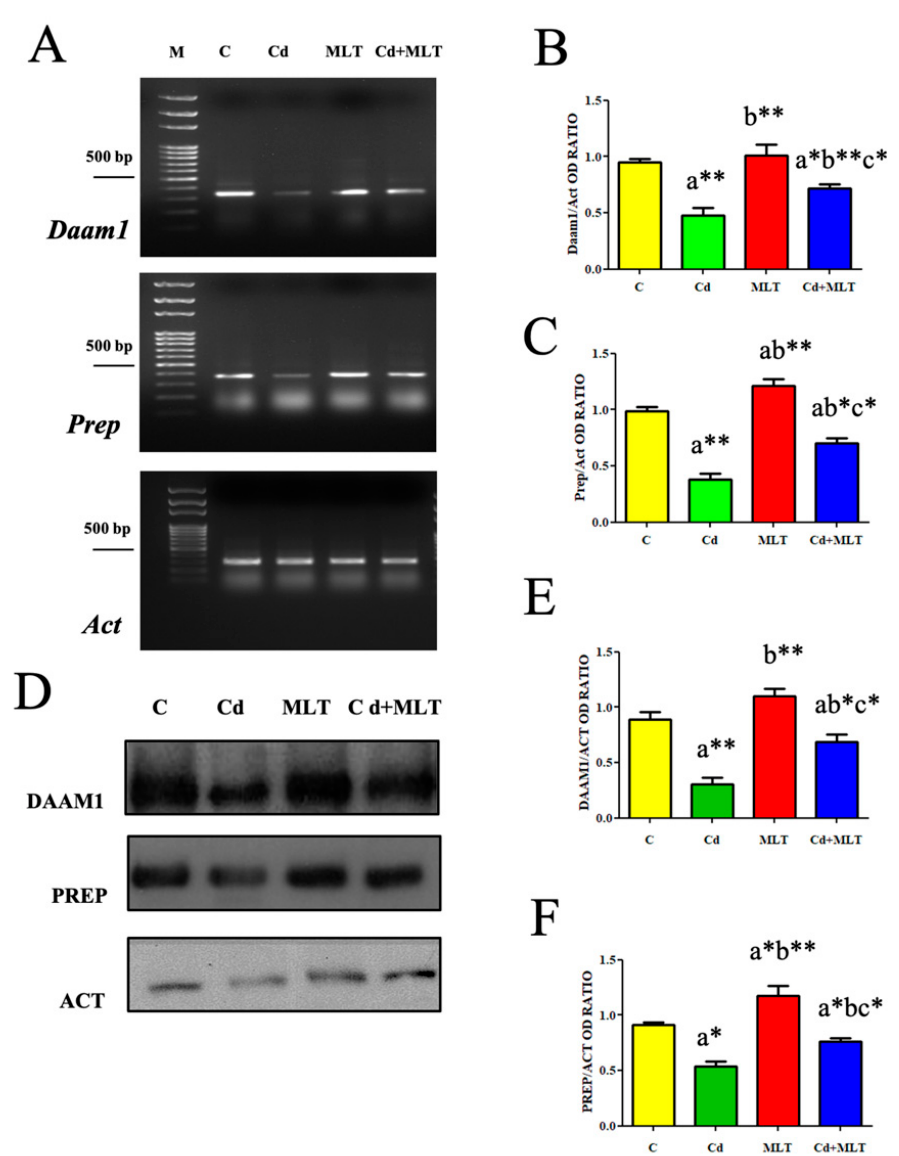
Figure 4. DAAM1 and PREP gene and protein expression of C-, Cd-, and/or MLT-treated rat testis. ( A ) Agarose gel electrophoresis of RT-PCR products showing the expression of Daam1 (380 bp), Prep (392 bp), and β -actin (300 bp) in testes of animals treated with Cd and/or MLT. M: represents base-pairs marker (Solis BioDyne, Tartu, Estonia). ( B , C ) Histograms showing the relative mRNA levels of Daam1 and Prep , respectively. Data were normalized with β - actin and reported as OD ratio. ( D ) WB analysis showing the protein levels of DAAM1 (112 kDa), PREP (80 kDa), and β -actin (44 kDa) in testes of animals treated with Cd and/or MLT. ( E , F ) Histograms showing the relative protein levels of DAAM1 and PREP, respectively. Data were normalized with β -actin and reported as OD ratio. All the values are expressed as means ± SEM from 6 animals in each group. a: significant difference versus C group, p < 0.05; b: significant difference versus Cd group, p < 0.05; c: significant difference versus MLT group, p < 0.05; *: p < 0.01; **: p <